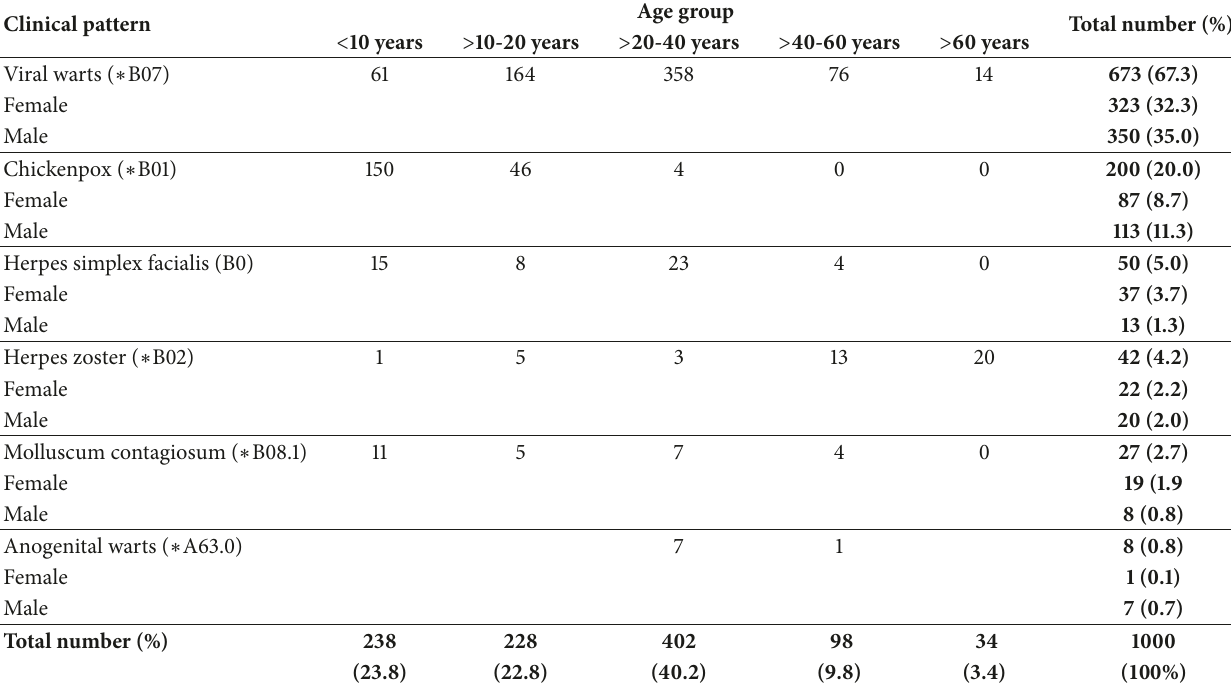
Table 1: The clinical patterns, frequencies, and percentages of viral skin infections at different age groups and in both sexes (total number =